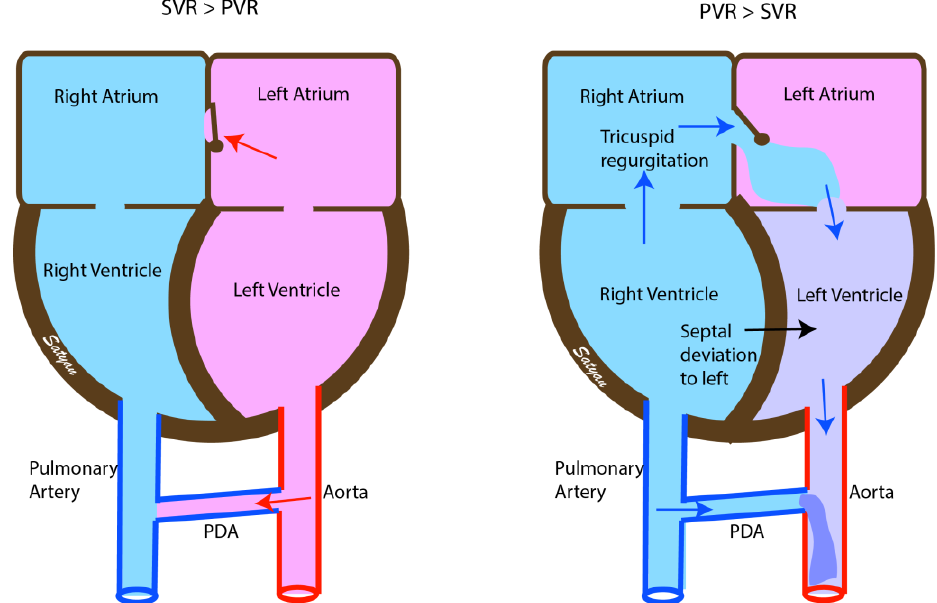
Figure 2. Echocardiographic findings in normal infants ( left ) and in PPHN ( right ). Soon after birth the pressures within the left-sided chambers of the heart are higher than in the right and the fetal shunts are reversed. The interatrial shunt and the shunt across the patent ductus arteriosus (PDA) is left to right. In infants with PPHN the pressures remain elevated in the right atrium and ventricle with right to left shunt at the atrial level and at the PDA causing desaturation (due to interatrial shunt) and differential cyanosis (due to PDA). There is right ventricular hypertrophy with bulging of the interventricular septum to the left and tricuspid regurgitation. SVR—Systemic vascular resistance, PVR—Pulmonary vascular resistance. Copyright Satyan Lakshminrusimha.